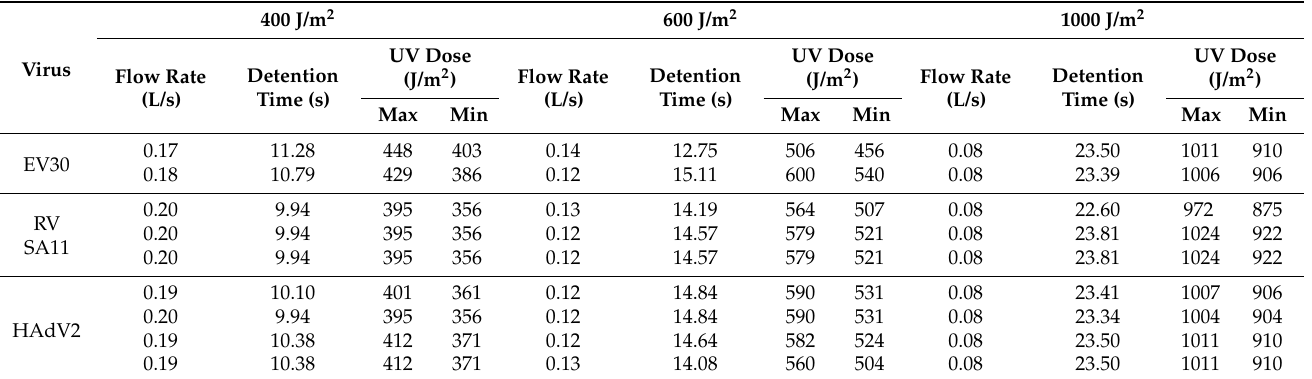
Table 1. UV dose for the EV30, RV SA11, and HAdV2 inactivation at various flow rates in tap water with UV transmittance values at 94% (max) and 85%